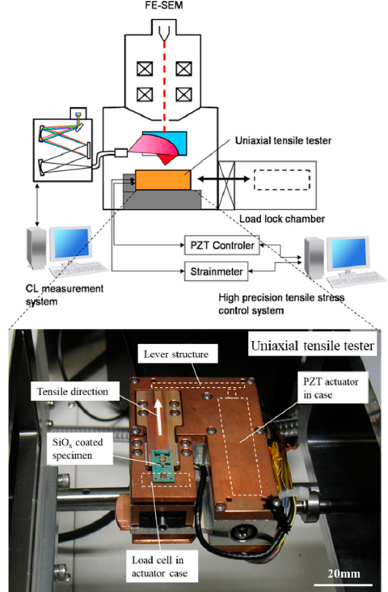
Figure 1. Schematic of the uniaxial tensile testing system along with the photograph of the uniaxial tensile tester.